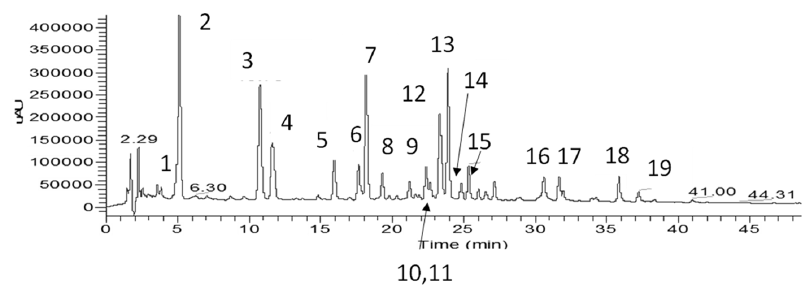
Figure 4. Representative HPLC–PDA–MS chromatogram of the MeOH extract of Matricaria recutita flowers. Experimental conditions: column: Zorbax SbAq RP ‐ C18 (150 × 3.0 mm), particle size of 5 μ m (Agilent) at 30 °C. Compounds detected: chlorogenic acid ( 1 ), cis ‐ 2 ‐ hydroxy ‐ 4 ‐ methox ‐ ycinnamic ‐ oxo ‐ 2 ‐Ο‐β‐ D ‐ glucopyranoside ( 2 ), trans ‐ 2 ‐ hydroxy ‐ 4 ‐ methoxycinnamic ‐ oxo ‐ 2 ‐Ο‐β‐ D ‐ glucopyranoside ( 3 ), quercetagenin ‐ 3 ‐Ο‐ glucoside ( 4 ), quercetin ‐ 7 ‐Ο‐ glucoside ( 5 ), patuletin ‐ 7 ‐Ο‐ glucoside ( 6 ), patuletin ‐ 3 ‐Ο‐ glucoside ( 7 ), luteolin ‐ 7 ‐Ο‐ glucoside ( 8 ), unknown ( 9 ), isorhamnetin ‐ 7 ‐ Ο‐ hexoside ( 10 ), isorhamnetin ‐ 3 ‐Ο‐ glucoside ( 11 ), 3,5 ‐ O ‐ dicaffeoylquinic acid ( 12 ), apigenin ‐ 7 ‐ O ‐ glucoside ( 13 ), chrysoeriol ‐ 7 ‐ O ‐ glucoside ( 14 ), 4,5 ‐ O ‐ dicaffeoylquinic acid ( 15 ), apigenin ‐ 4 ′‐ acetyl ‐ hexoside (tentatively identified) ( 16 ), apigenin ‐ 7 ‐ acetyl ‐ hexoside ( 17 ), apigenin ‐ 7 ‐ acetyl hexoside isomer ( 18 ), apigenin ‐ 7 ‐ O ‐ (6 ″‐ malonyl) ‐ glucoside ( 19 ).